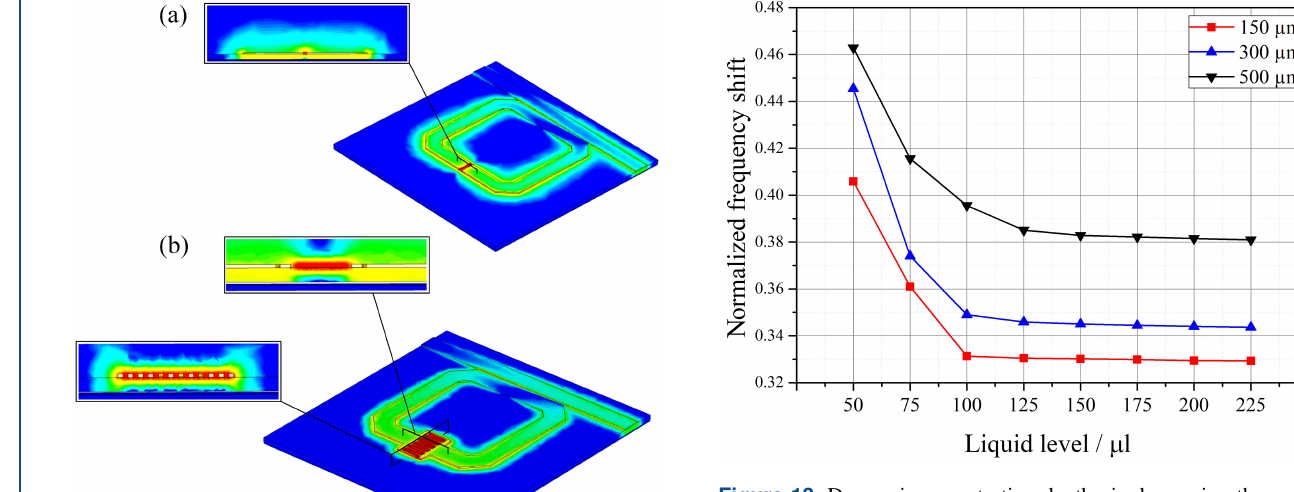
Figure 13. Decreasing penetration depth via decreasing the space between the fingers of an interdigital structure.